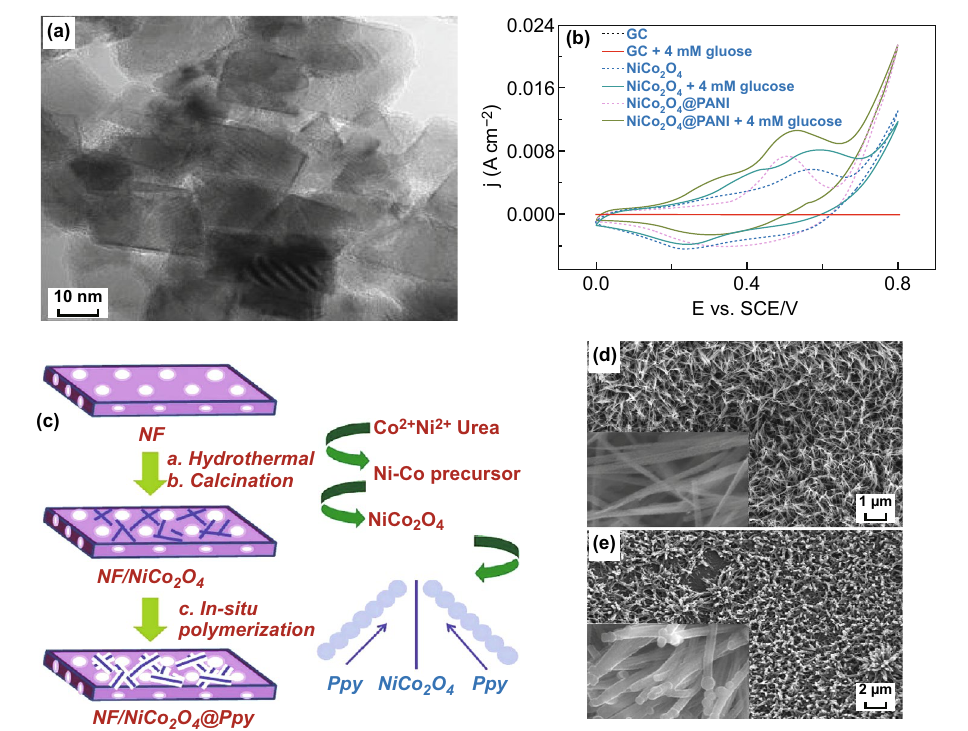
Fig. 29 a HRTEM image of NiCo 2 O 4 @PANI nanocomposite and b CV plots for different GCE electrodes in the absence and presence of 4 mM glucose in 0.1 M NaOH solution at scan rate = 50 mV s −1 . Reproduced with permission from Ref. [263]. Copyright © 2015 Elsevier B.V. c Schematic illustration of the preparation of core–shell NiCo 2 O 4 @Ppy on Ni foam substrate. d FESEM image of bare NiCo 2 O 4 . e FESEM image of